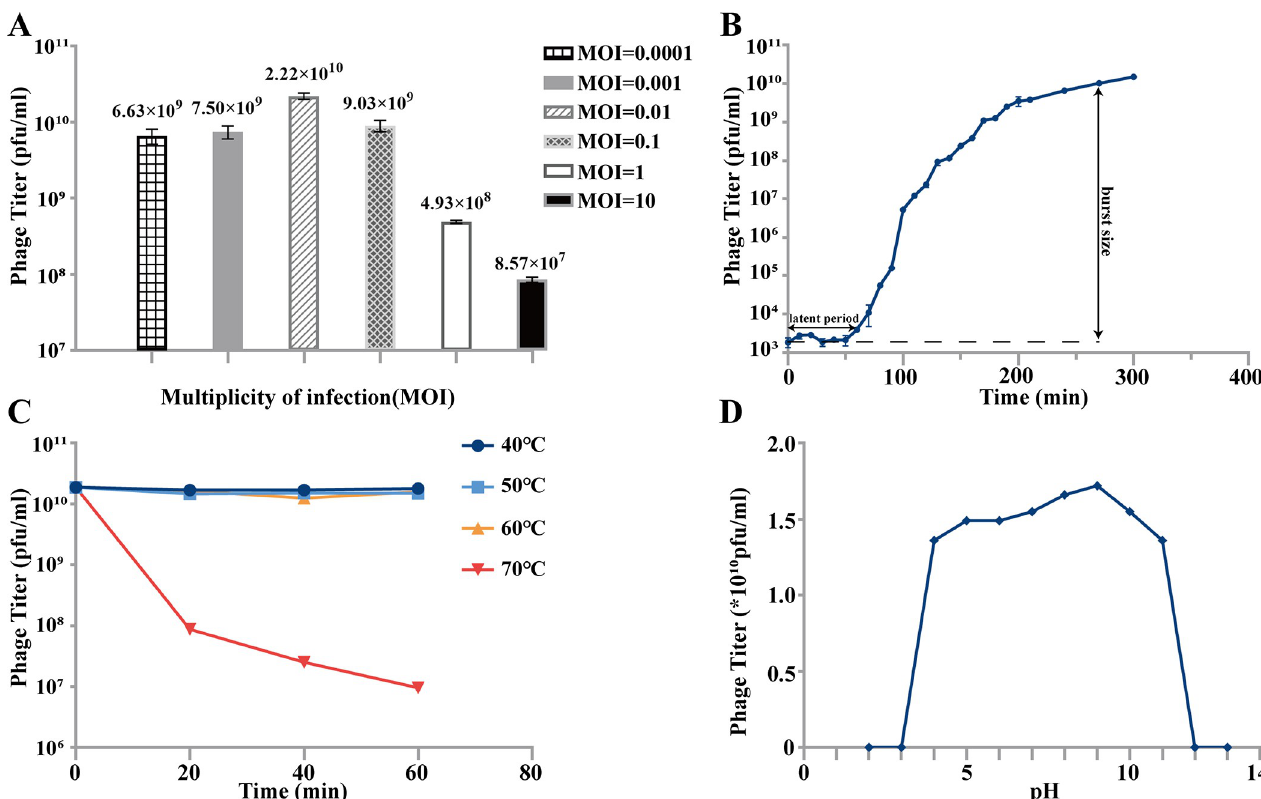
Fig 3. Biological characterization of the phage vB_VpS_PG28. (A) The multiplicity of infection (MOI) test of vB_VpS_PG28; (B) The one-step growth curve of phage vB_VpS_PG28, and data points show phage titers measured at ten-minute intervals; (C) Thermostability curve of vB_VpS_PG28, and data points are phage titers measured after incubating the phage at different temperatures for 20, 40 and 60 minutes respectively. (D) pH stability of vB_VpS_PG28, and data points are phage titers measured after incubation of phage at different pH for 1h. All assays were performed in triplicate.